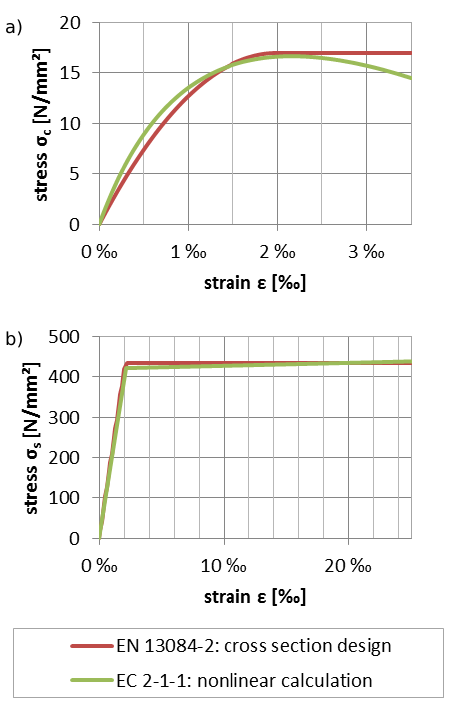
Figure 6. Stress-strain-curves for concrete (a) and reinforcement (b) according to